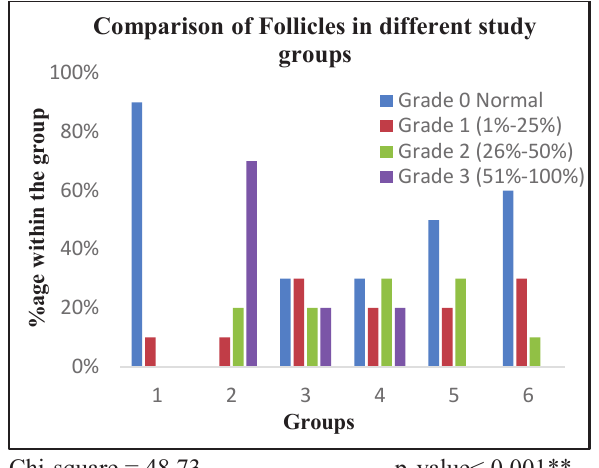
Graph 1: Comparison of Follicles in different study groups